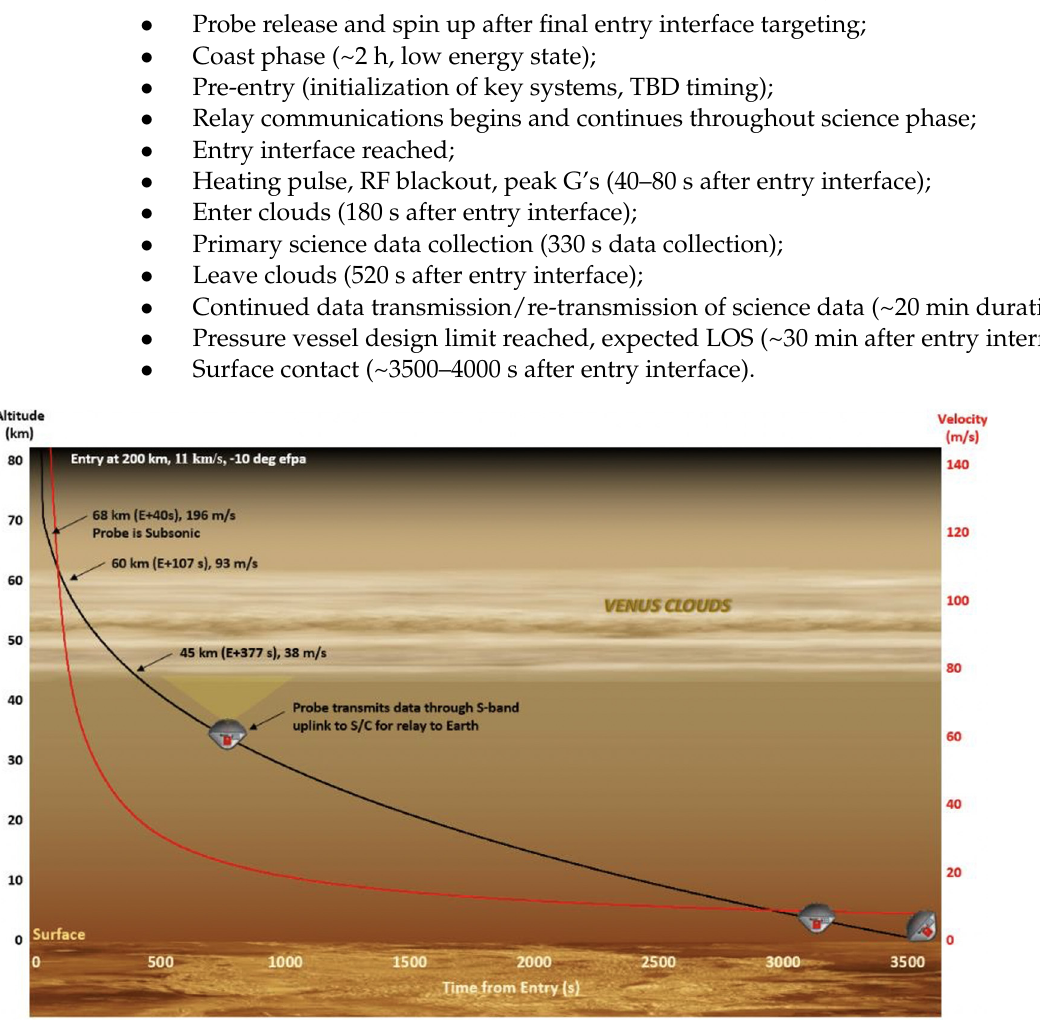
Figure 7. The science phase targets the Venus cloud layer between 45 and 60 km altitude, enabling ~330 s of science observations (Credit: NASA ARC). Through the cloud layer and below, the science data will be transmitted direct to Earth at optimized data rates. Objectives below the cloud layer, such as the potential to continue science observations with the primary instrument or to return environmental data will be performed on a best effort basis